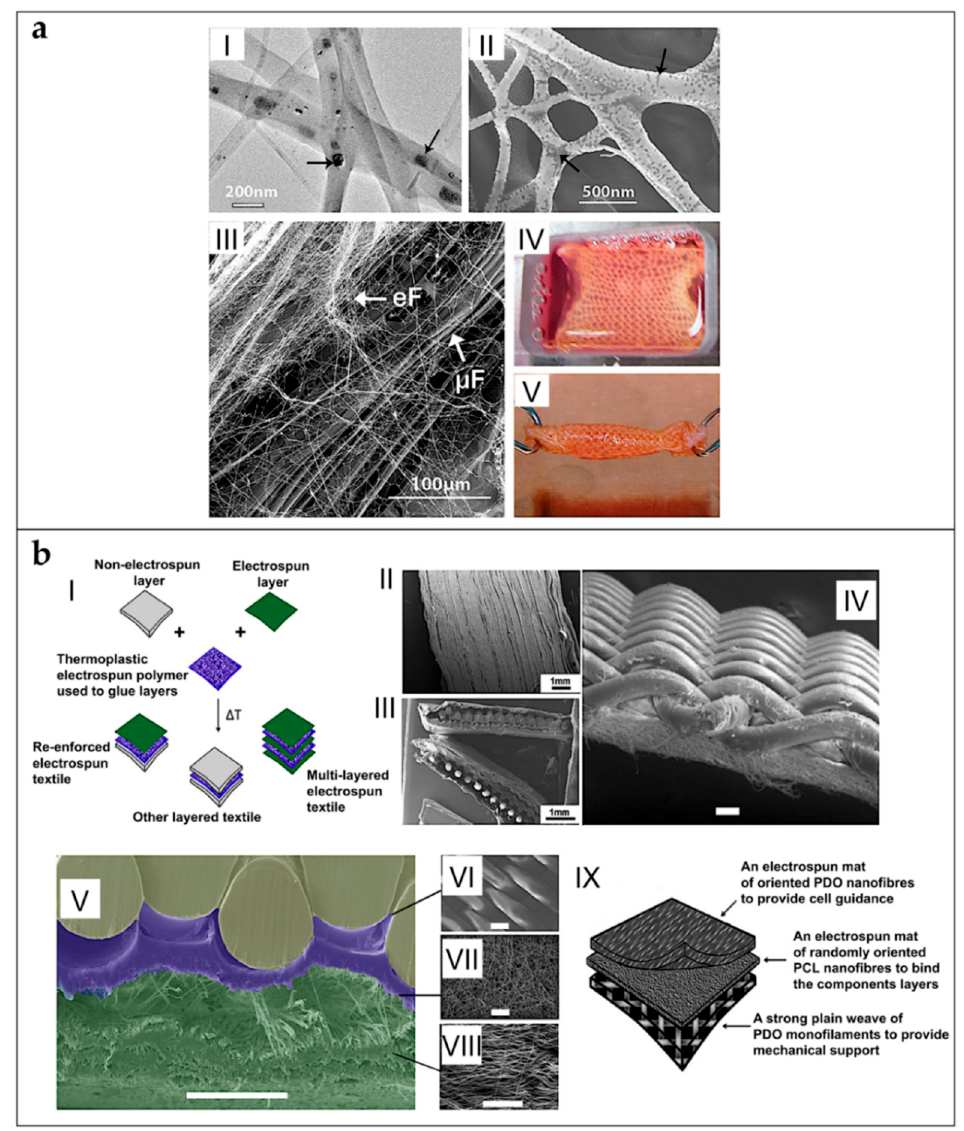
Figure 10. Different scaffolds used as in vivo patches or augmentations for tendon and ligament